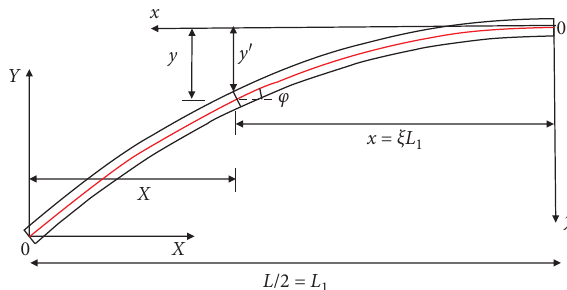
Figure 4: Schematic diagram of arch circle